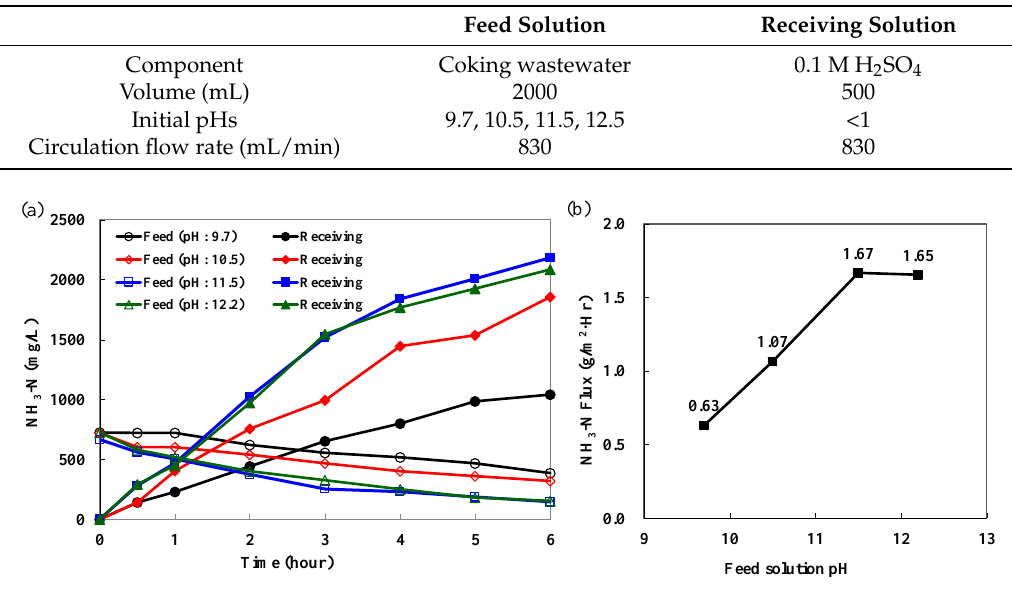
Figure 7. ( a ) the NH 3 -N concentrations in both feed and receiving solutions as a function of time; ( b ) the NH 3 -N transmembrane flux as a function of pH.